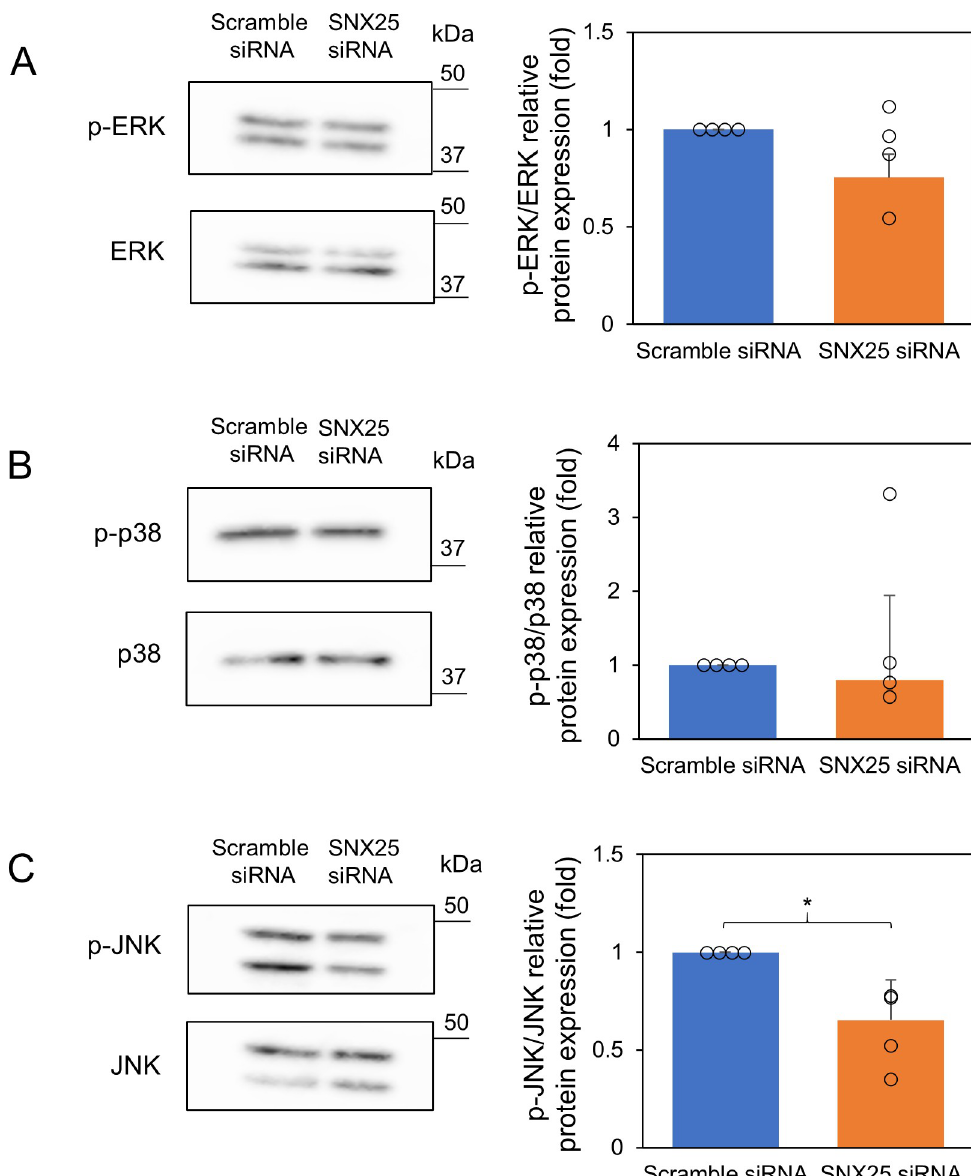
Fig 3. Activation of MAPK signaling pathways in SNX25 knockdown RAW 264.7 cells. (A–C) RAW 264.7 cells were stimulated with LPS (1 μ g/ml) for 20 min. The expression of p-ERK, p-p38 and p-JNK was analyzed by Western blotting. ERK, p38, and JNK were used as loading controls. Data are expressed as means ± SD. Circles indicate the individual experimental values. � P < 0.05, n = 4. the peak time, 10min after LPS stimulation (Fig 5C). As an alternative route for I κ B α degrada- tion, ubiquitination of I κ B α might be promoted by SNX25 knockdown. To test this possibility, SNX25 knockdown cells and control cells were treated with the proteasome inhibitor MG132 (5 μ M, 1 h) and then subjected to Western blotting with p-I κ B α antibody. An increased level of poly-ubiquitinated I κ B α was observed in SNX25 knockdown cells compared with control cells after 10 min LPS stimulation (Fig 5D, Ub-I κ B α ). These results suggest that SNX25 nega- tively regulates ubiquitin-mediated I κ B α degradation.